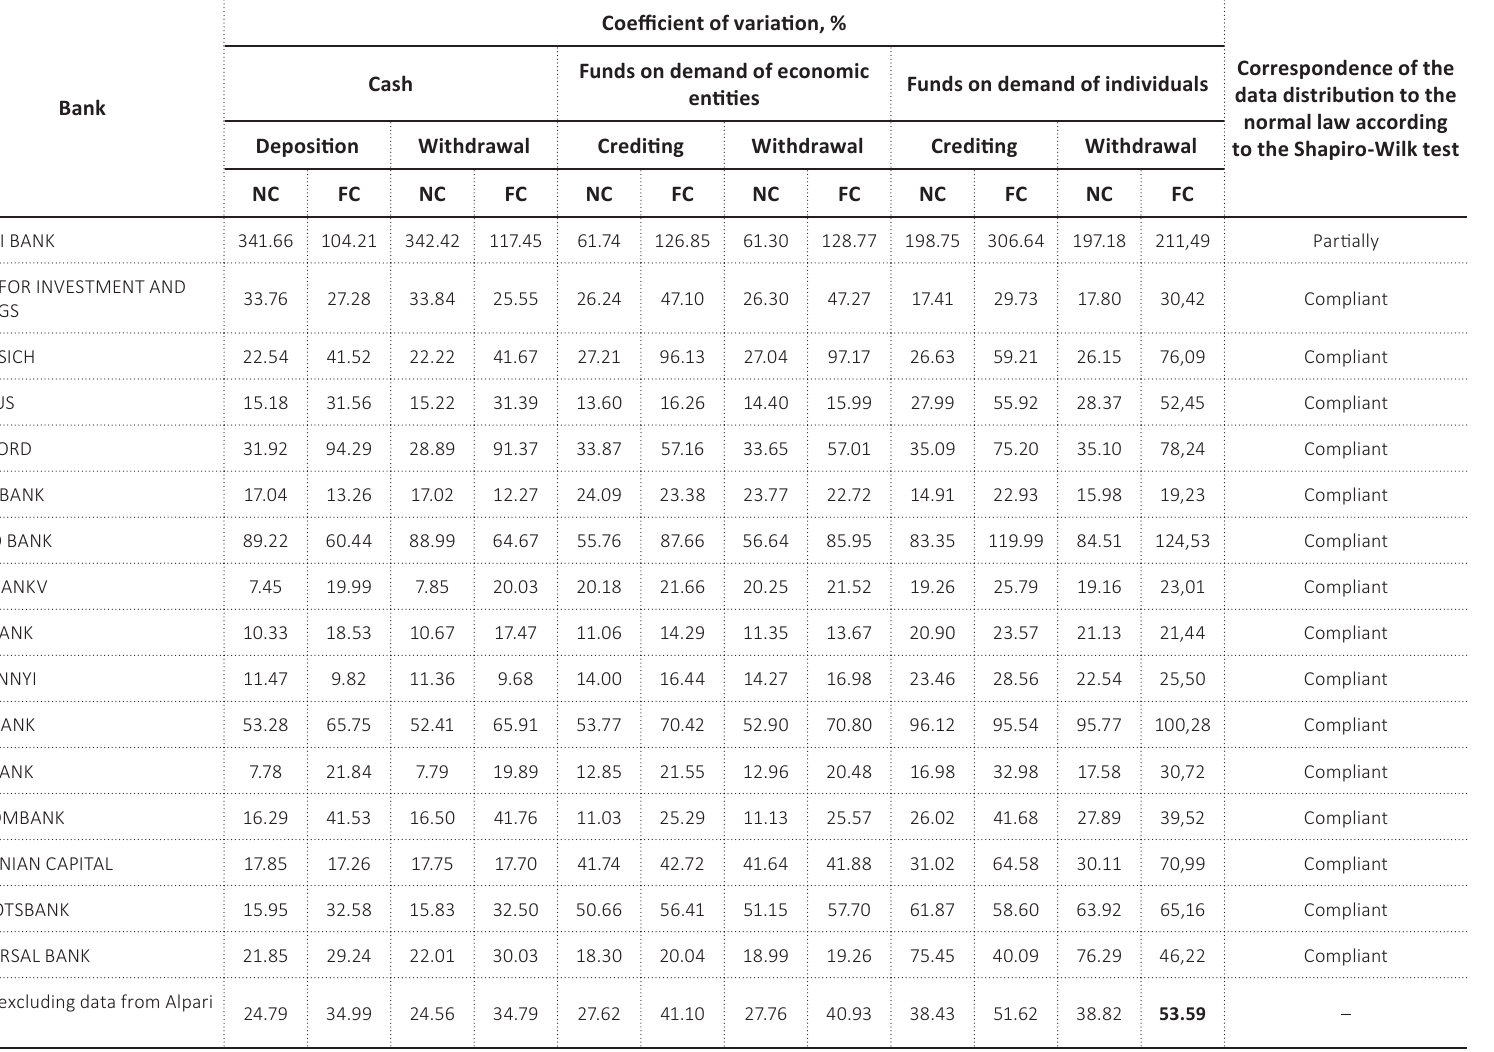
Coefficient of variation, % Cash